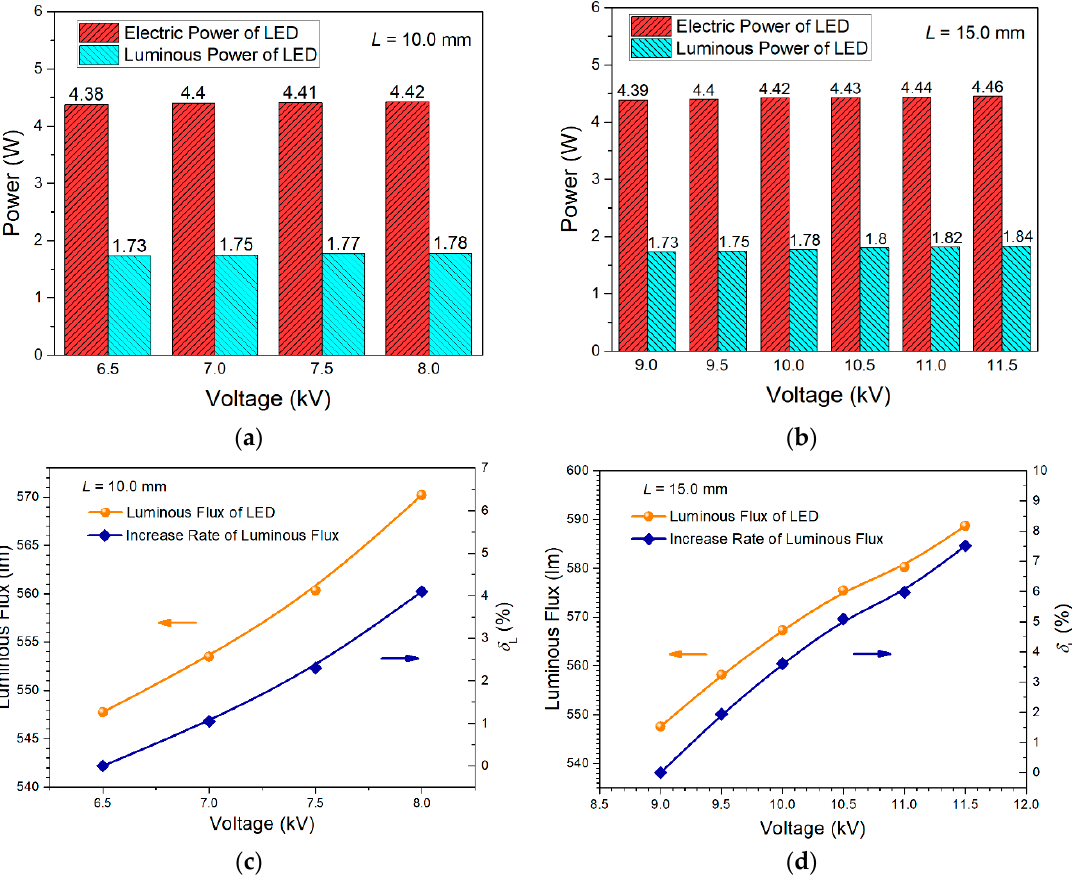
Figure 9. Light efficiency of LED filament bulb under ionic wind: ( a ) electric power and luminous power of LED filament bulb with electrode gap 10.0 mm; ( b ) electric power and luminous power of LED filament bulb with electrode gap 15.0 mm; ( c ) luminous flux of LED filament bulb with electrode gap 10.0 mm; and, ( d ) luminous flux of LED filament bulb with electrode gap 15.0 mm.